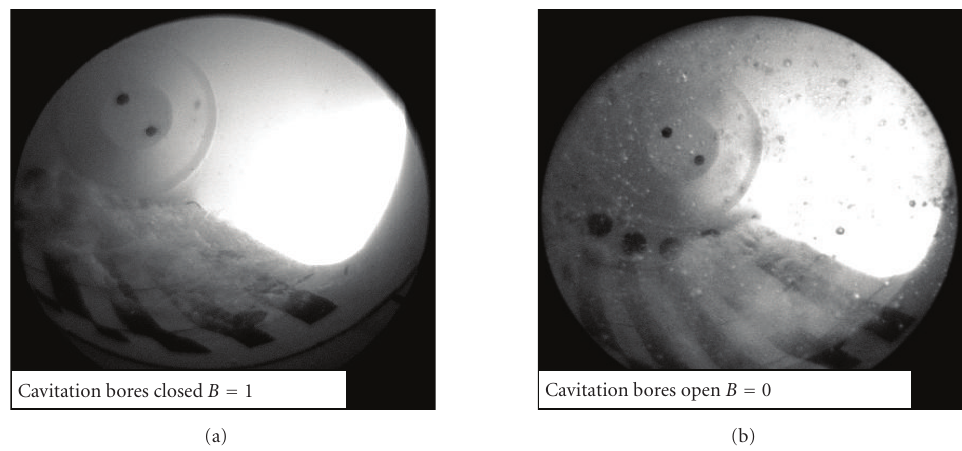
Figure 13: Cavitation at NPSH A = 8m with/without cavitation bores at BEP ( n = 725 rpm).